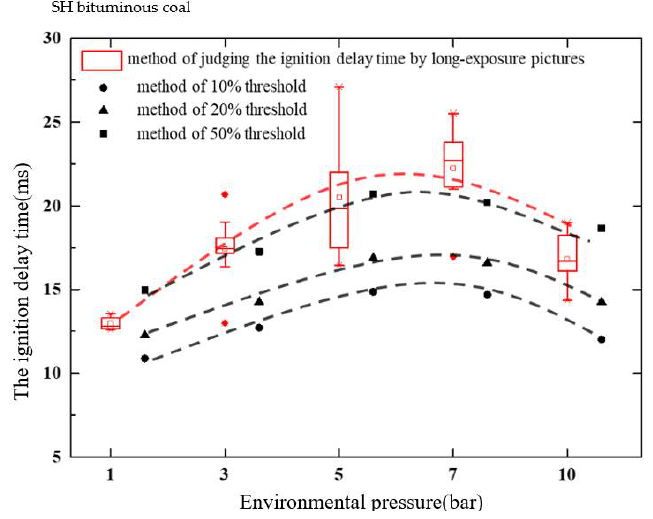
Figure 7. Comparison of the method used for judging the ignition delay time by long-exposure pictures and micro-particle statistics. Table 1. Experimental conditions and gas compositions of the flue gas.